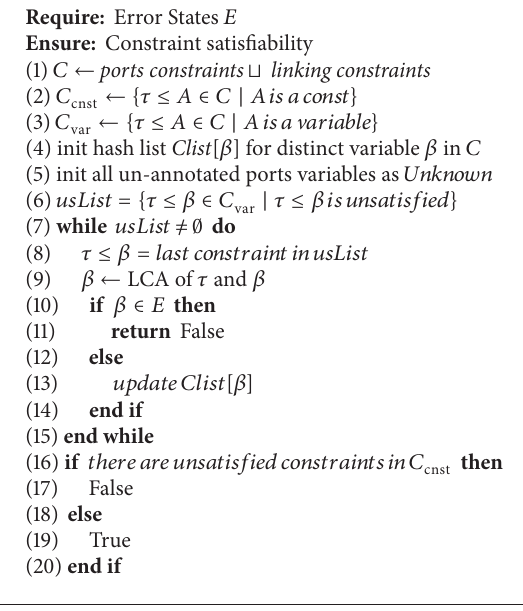
Algorithm 1: The algorithm 𝐷 + of constraint